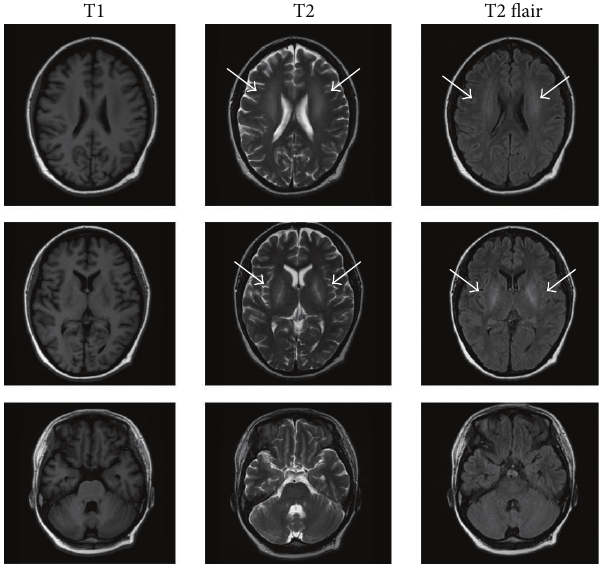
Figure 1: Brain MR imaging (T2WI ⋅ FLAIR) revealed bilateral symmetrical high signal intensities in the globus pallidi (arrows), cerebral hemispheres (triangles), and cerebral peduncles.